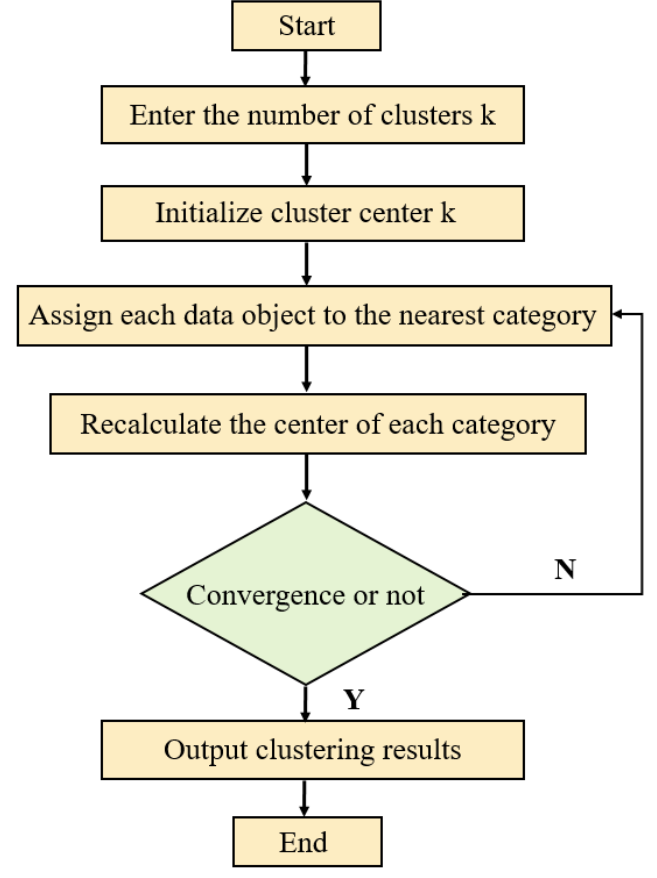
Figure 6. K-means algorithm execution process.